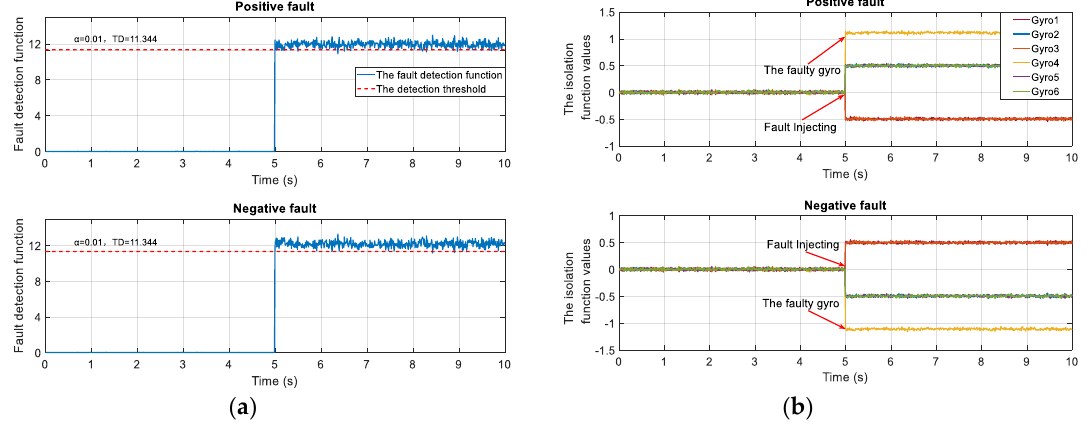
Figure 2. The fault detection and isolation function in two cases: ( a ) The detection functions of positive fault and negative fault; ( b ) The isolation functions of positive fault and negative fault.